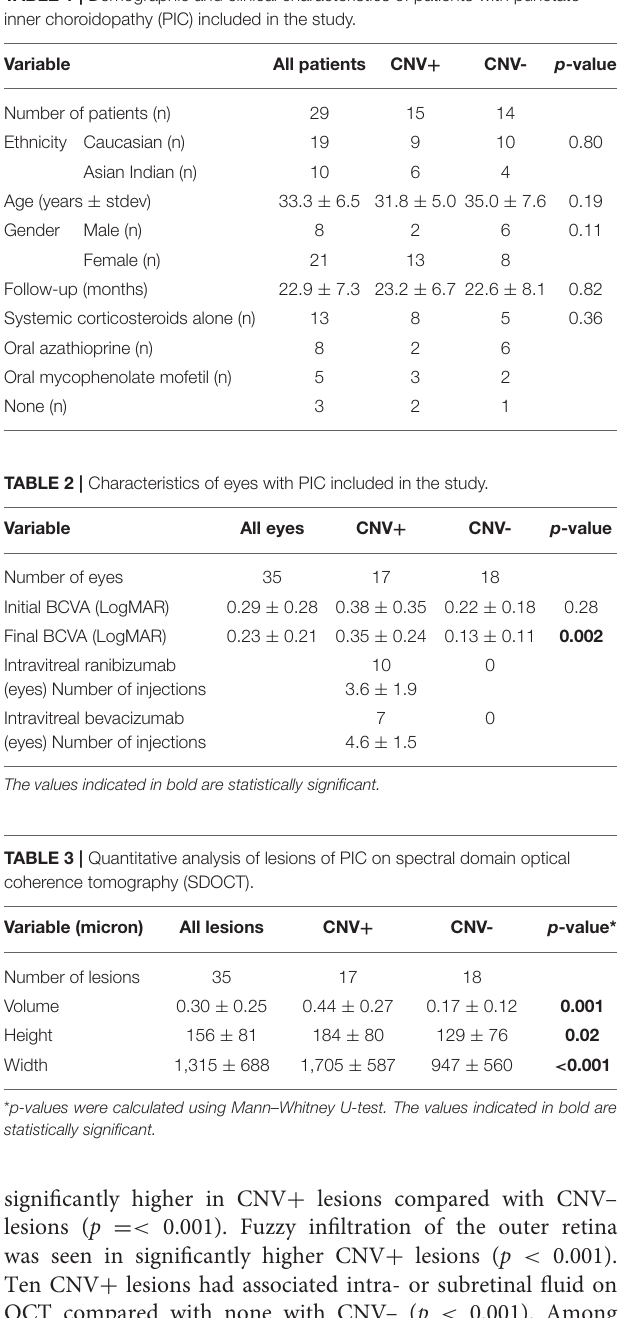
TABLE 4 | Qualitative features PIC lesions on